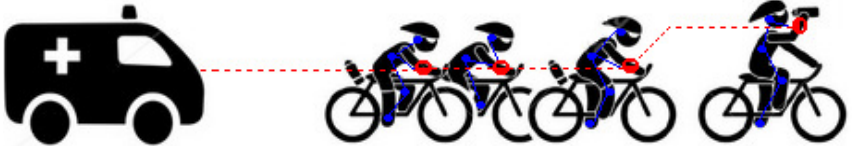
Figure 2. Body-to-body network for the performance monitoring of a group of athletes c (cid:13) [2019] IEEE. Reprinted, with permission, from